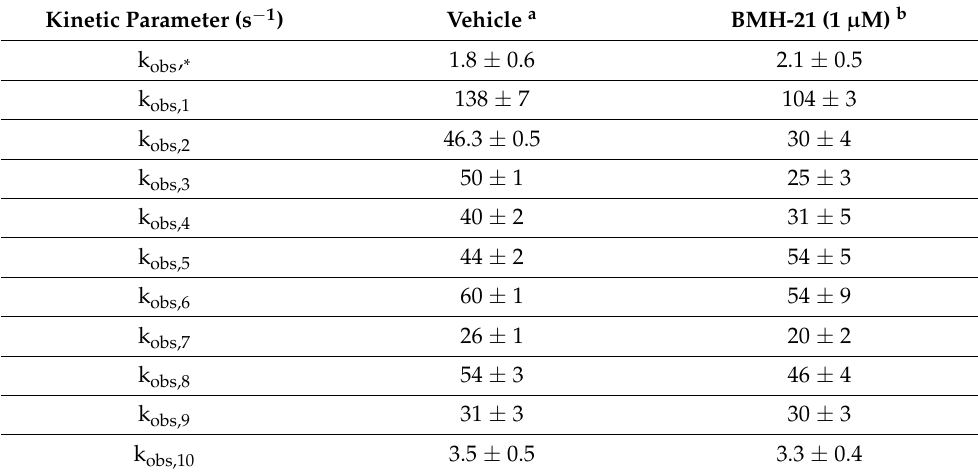
Table 3. Resultant parameter values from Pol III vehicle- and BMH-21-treated multi-nucleotide time